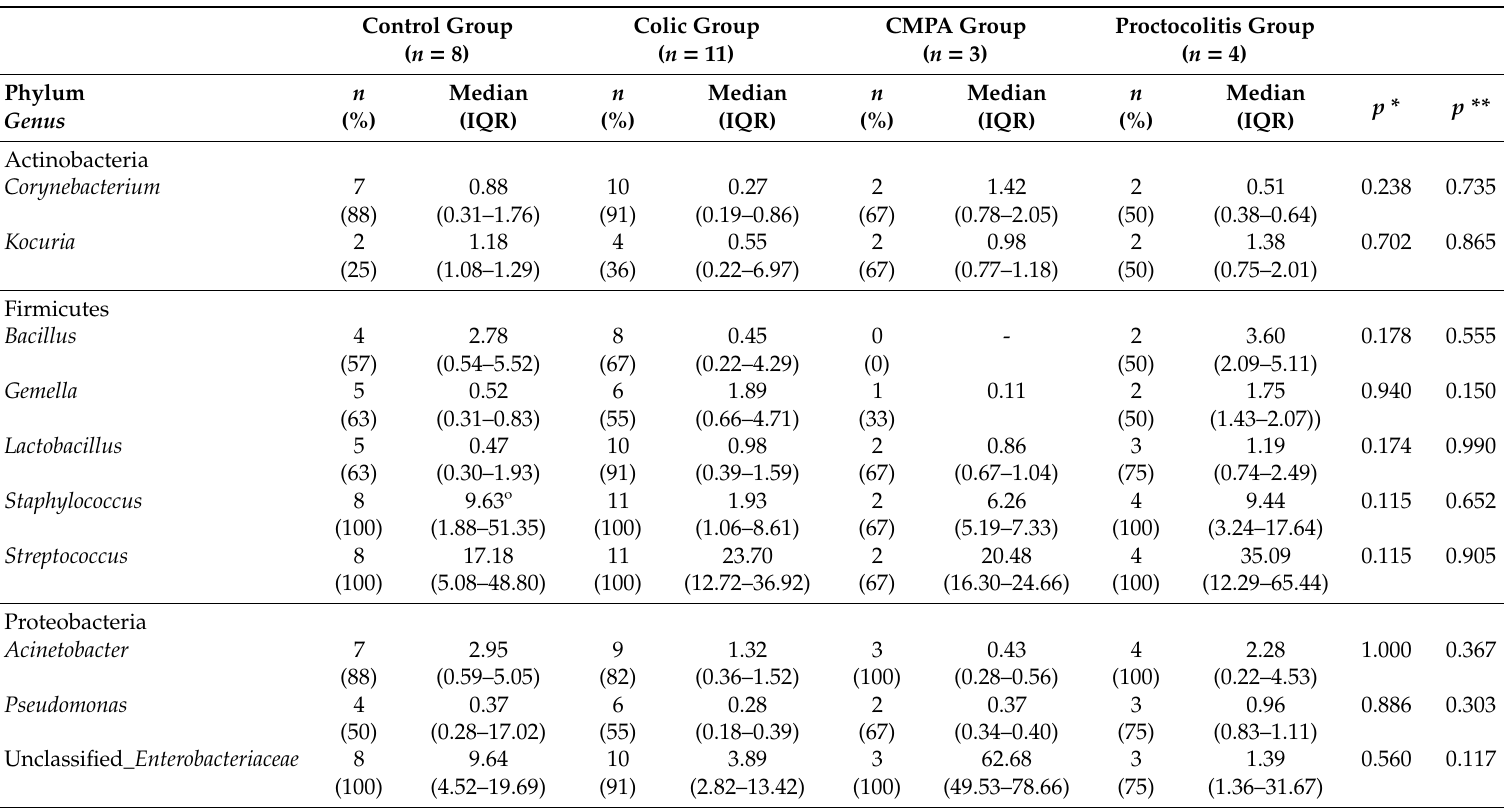
Table 3. Frequency and relative abundance of operational taxonomic units at genus level in milk samples from participants ( N = 26) in each group of study: control, colic, cow’s milk protein allergy (CMPA), and